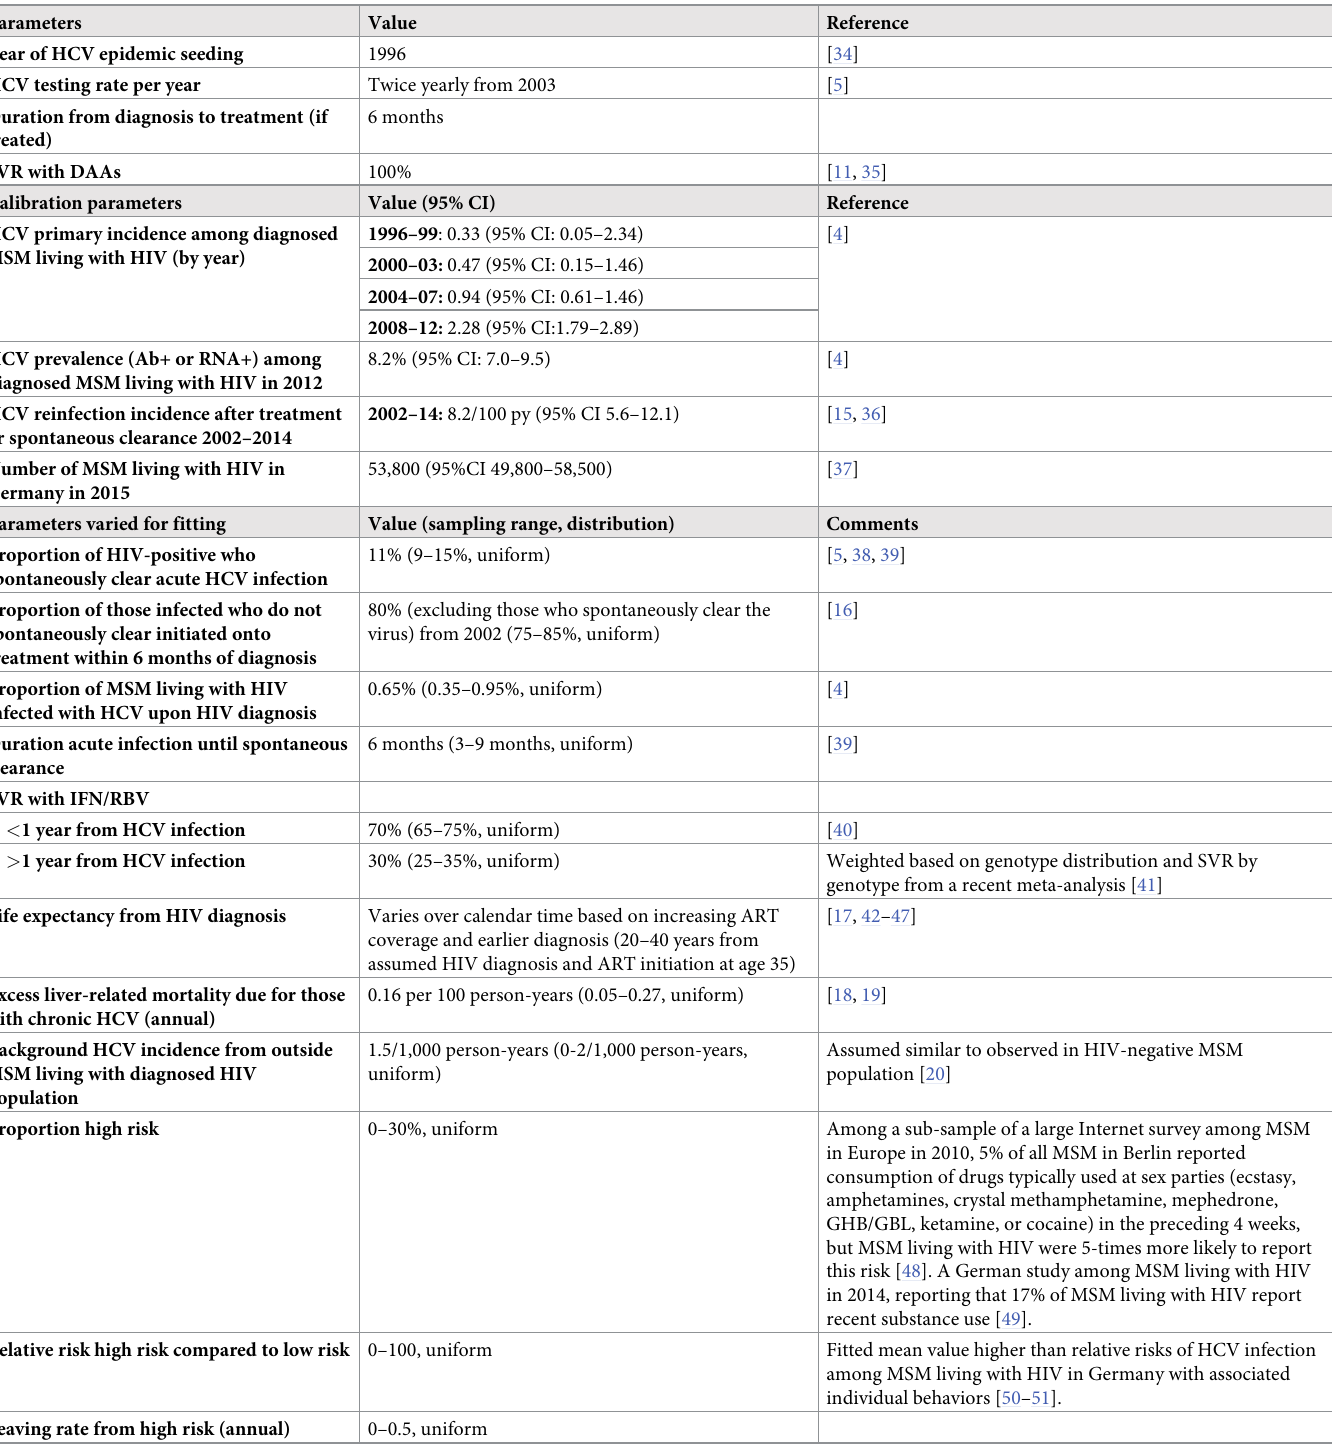
Table 1. Model parameterization and